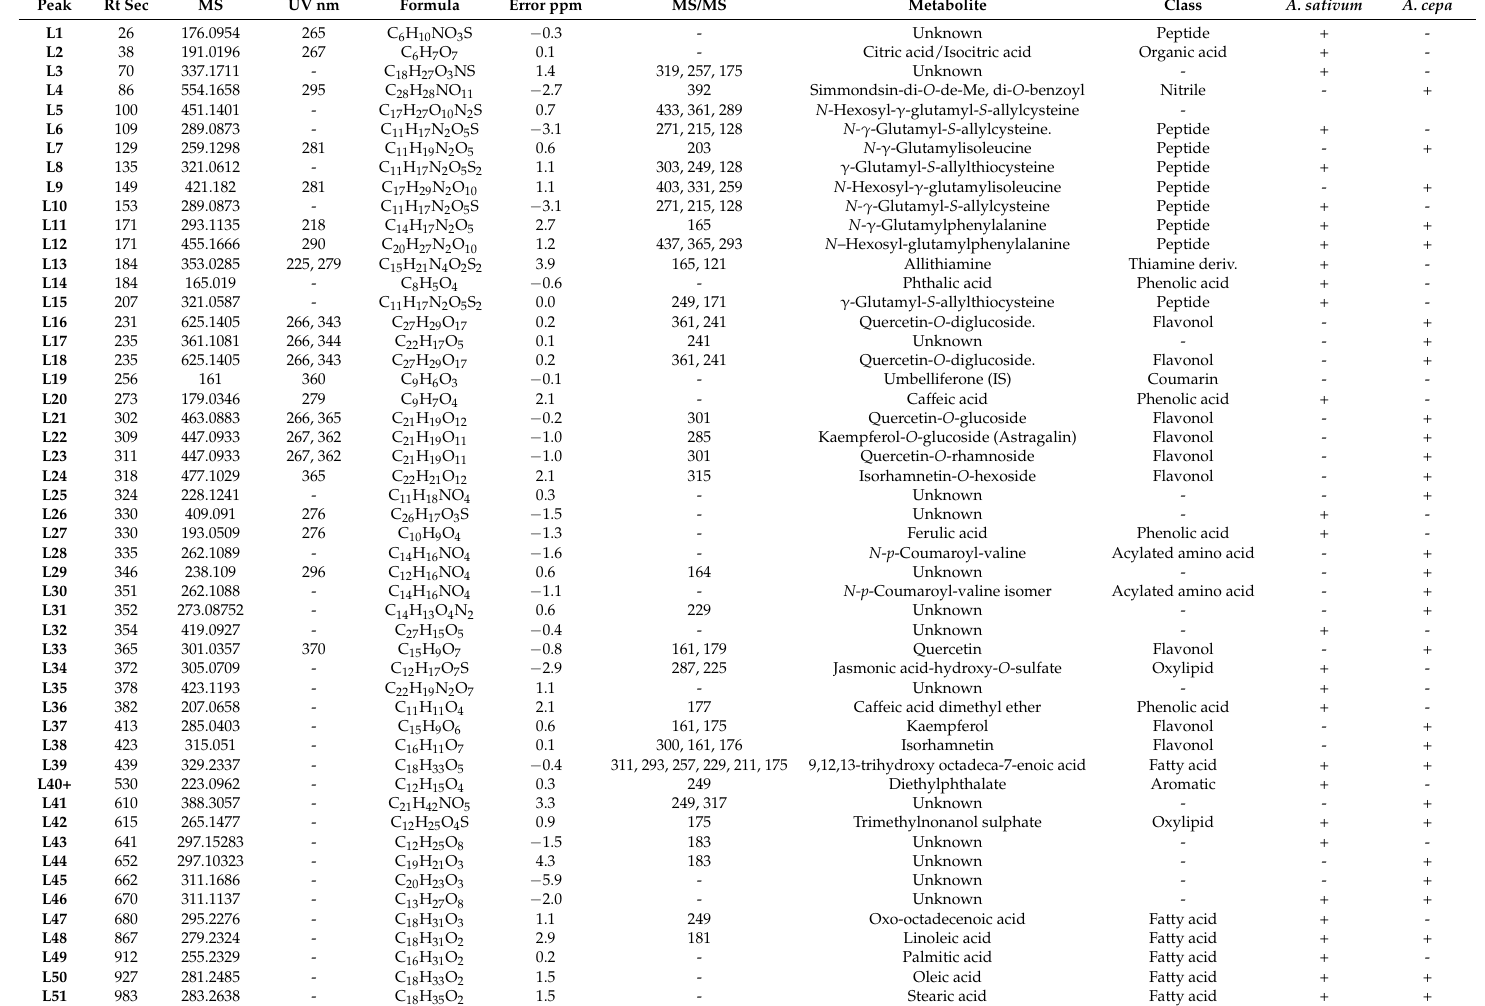
Table 2. Metabolites identified via UPLC/PDA/orbitrap-MS in methanol extracts of A. sativum and A. cepa red cv. extracts using negative and positive ionization